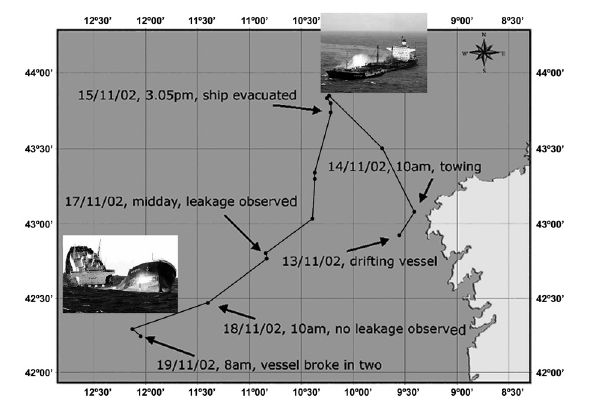
Fig . 2. – Trajectory followed by the Prestige tanker between the first emergency call to the day of the sinking. Taken from